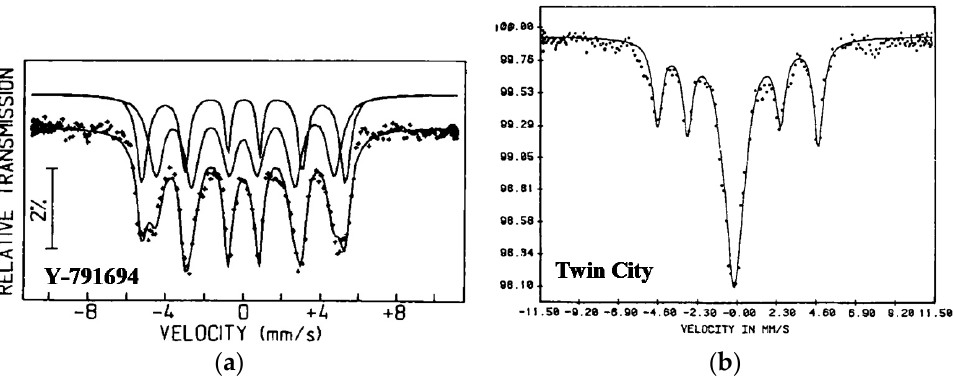
Figure 23. Room temperature Mössbauer spectra of iron meteorites: Y-791694 IAB complex ( a ) and Twin City IAB-ung ( b ). Indicated spectral components are the results of the fits. Adapted from [67].